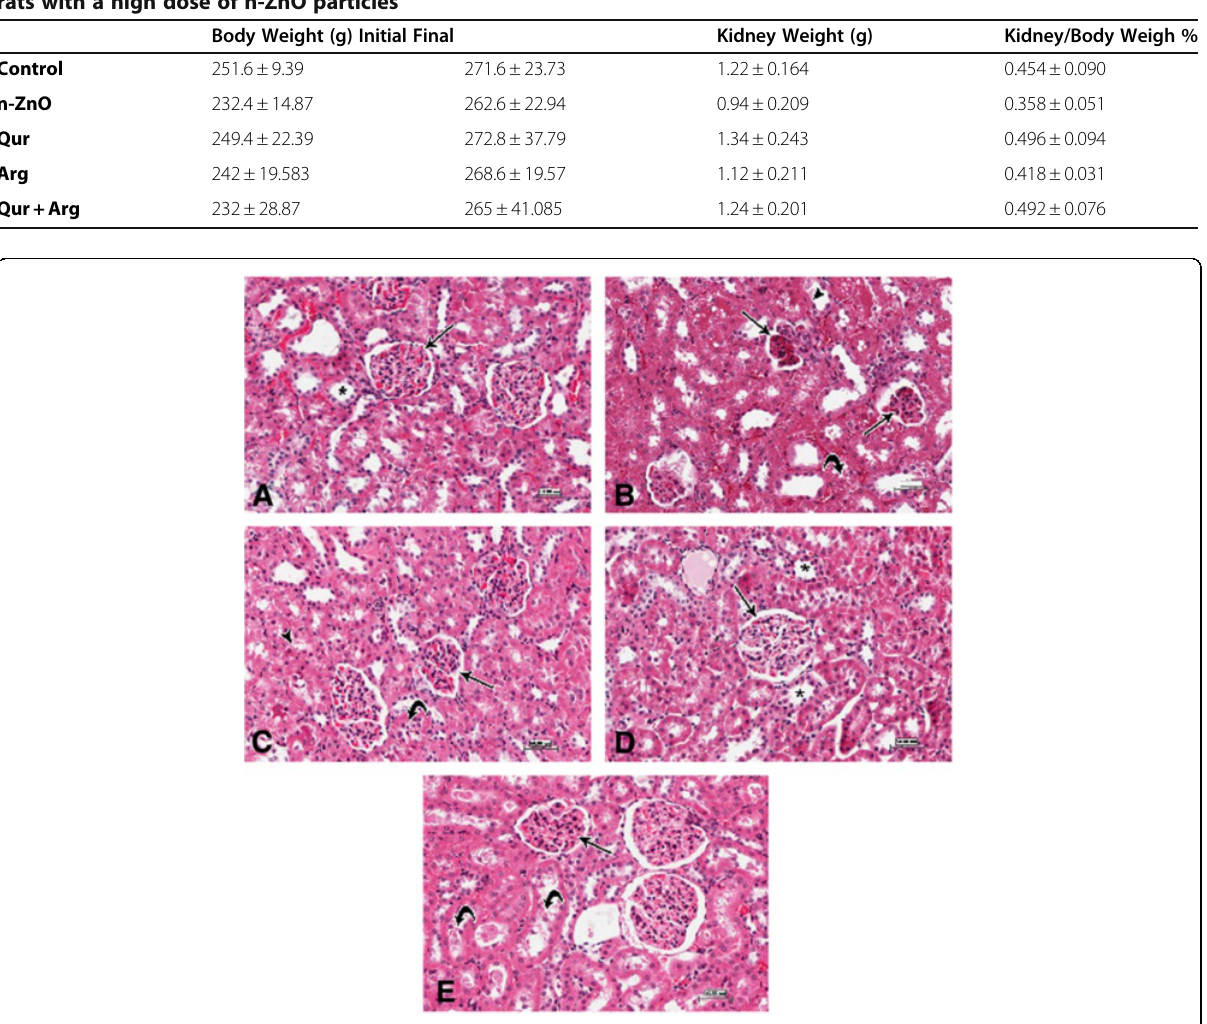
Table 6 Effect of Qur and/or Arg treatment on body weight, kidney weight, and kidney/body weight % in intoxicated rats with a high dose of n-ZnO particles